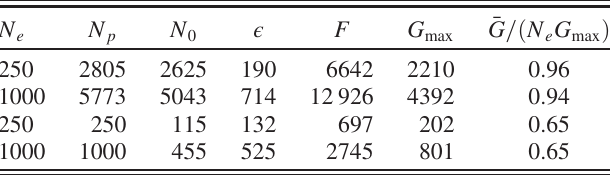
and ϵ > 0 . 99 ϵ max